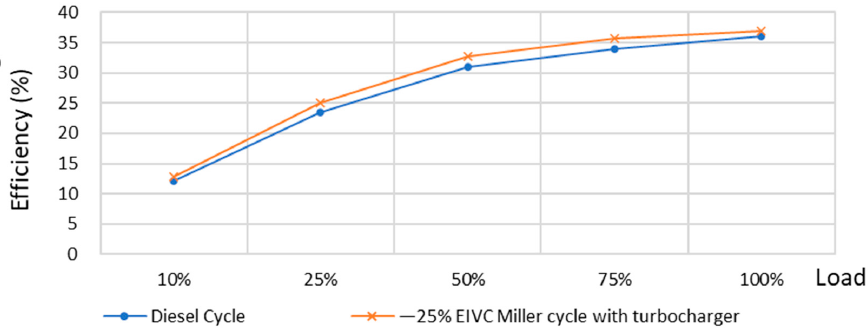
Figure 11. Comparison of BP between diesel engine and EIVC Miller cycle turbocharger diesel engine.